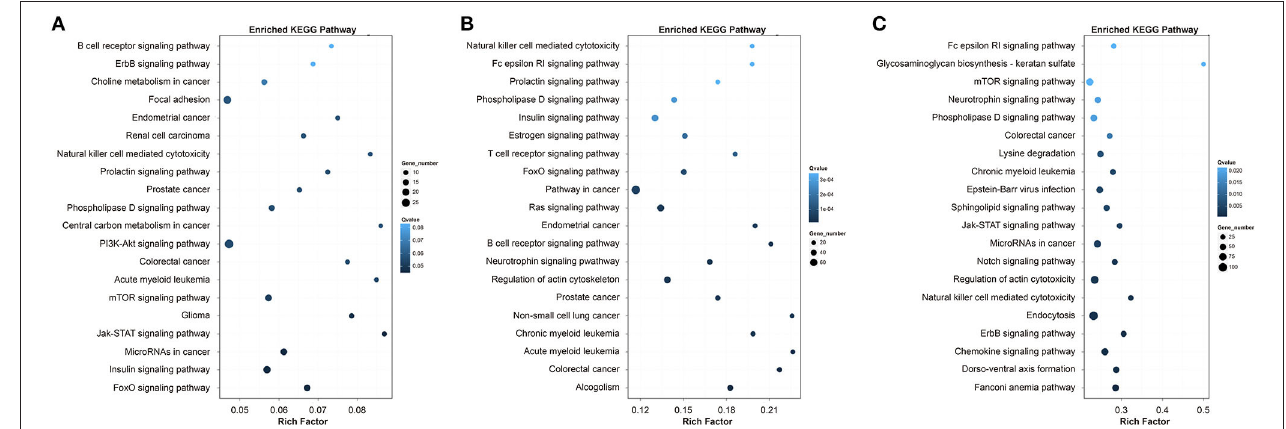
FIGURE 6 | Top 20 KEGG pathways for the target genes of the DELs in Qiufeng vs. Baiyu (A) , Qiufeng vs. Nd-s D (B) and Qiufeng vs. Nd (C) . “Rich factor” indicates the ratio of the number of DEGs enriched in the pathway to the number of genes annotated in the